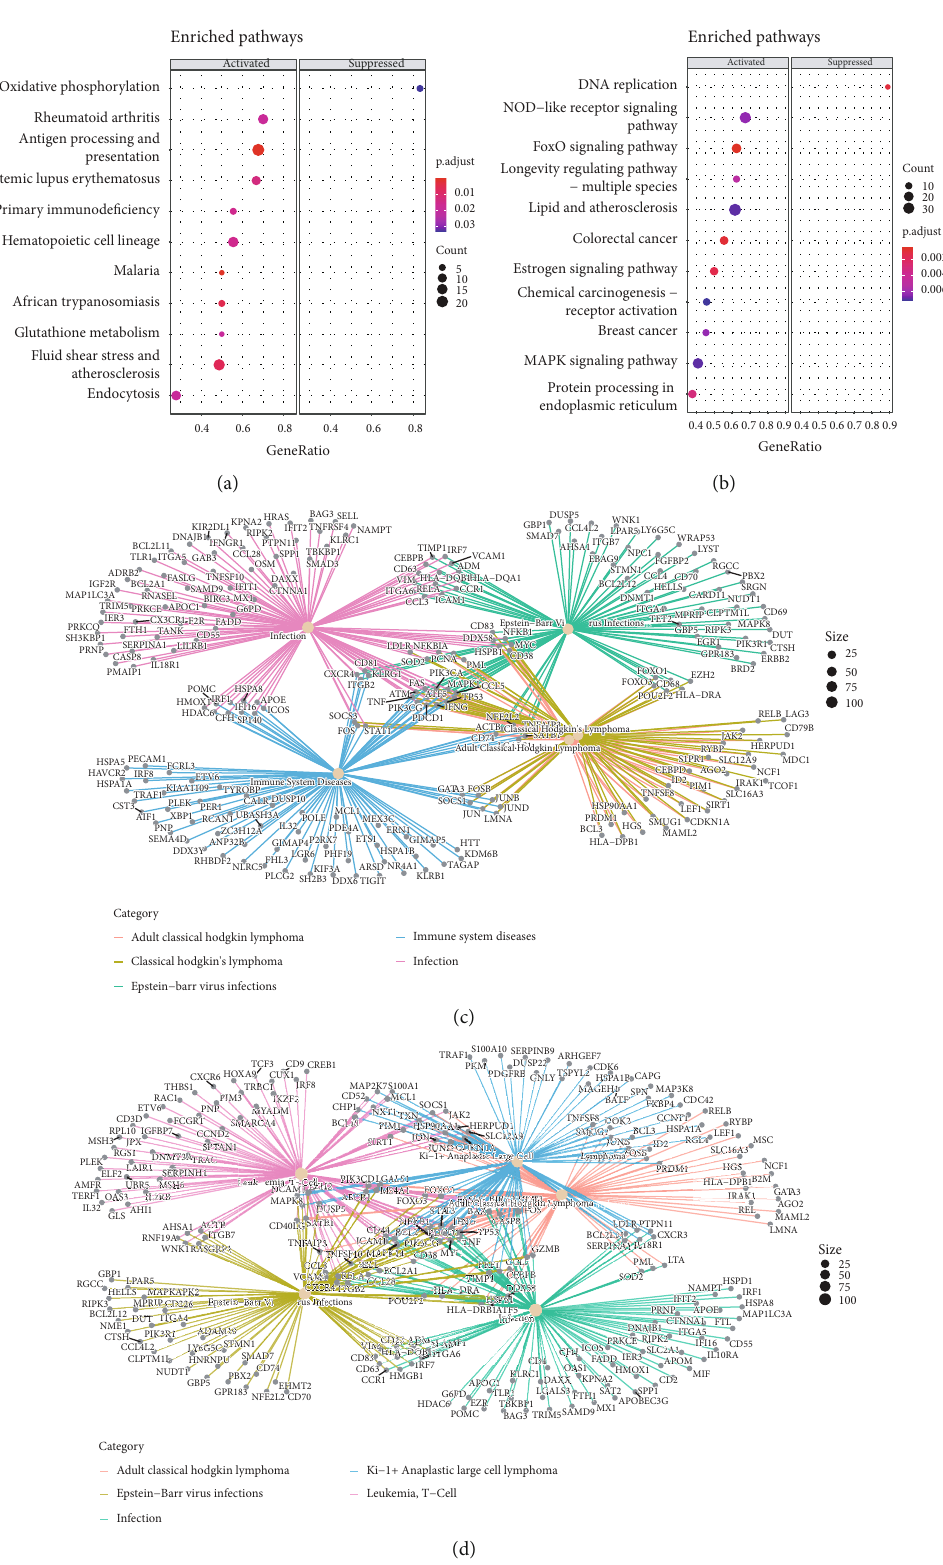
Figure 4: Functional analysis of natural killer (NK) cell subpopulations NK(EGR1) and NK(CAPG). (a) Dot plot showing the up-/ downregulated pathways of NK(EGR1). (b) Dot plot showing the up-/downregulated pathways of NK(CAPG). (c)CNET plot showing the depth of NK(EGR1) and metastasis prediction. (d) CNET plot showing the depth of NK(CAPG) and metastasis